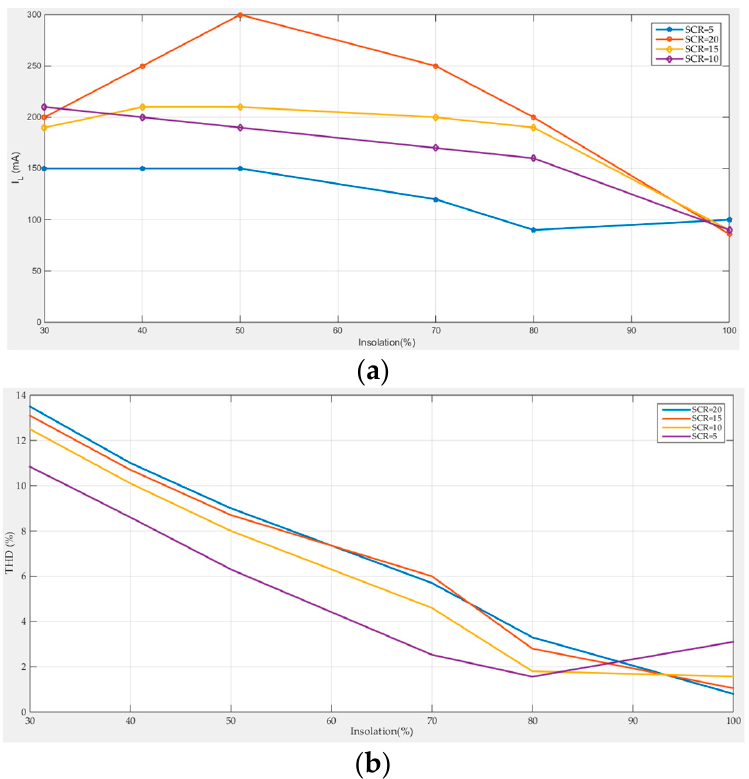
Figure 9. The effect of varying insolation levels and grid SCR on: ( a ) the RMS of the leakage current and ( b ) the THD of I g .